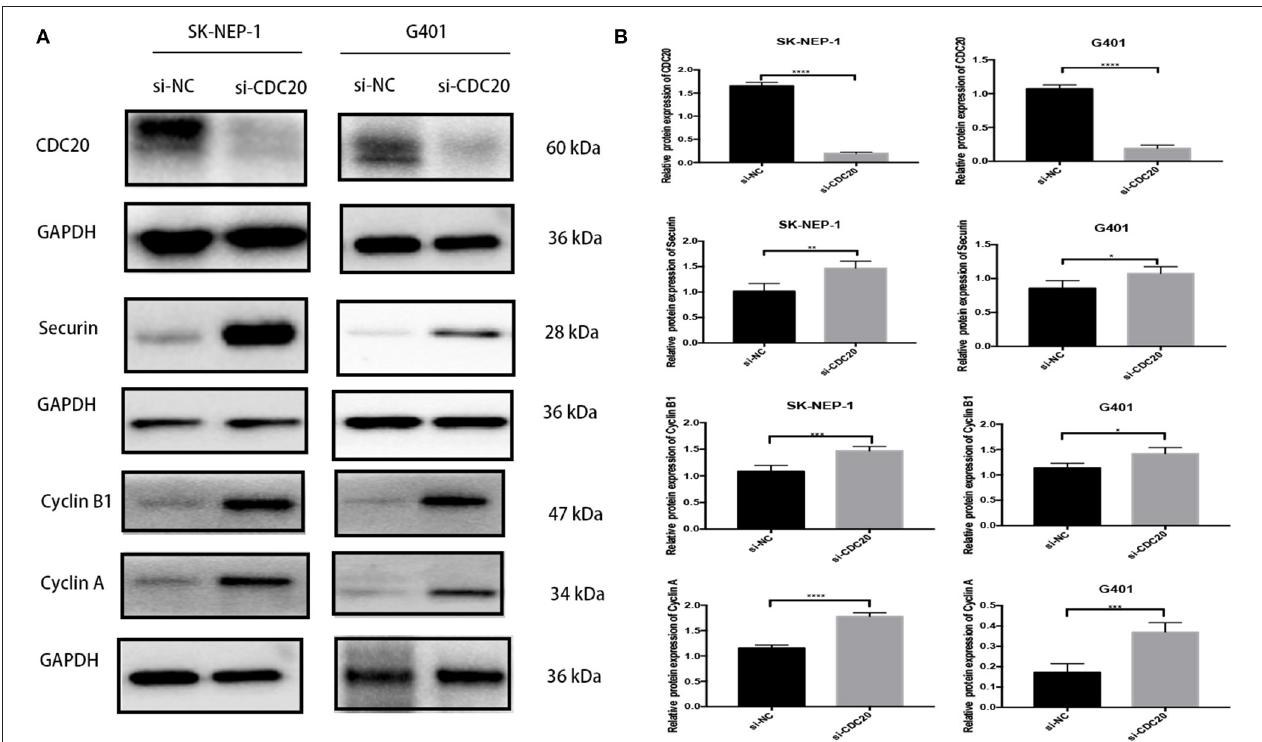
FIGURE 5 | Western blot analyses of proteins that regulate G2-to-M transition in WT cells lines inhibiting CDC20. Suppression of CDC20 protein expression by siRNA in SK-NEP-1 and G401 cells. Western blot analysis of CDC20, securin, cyclin B1, and cyclin A protein levels of the siCDC20 group compared with the NC group in SK-NEP-1 and G401 cells (A) . Quantification of CDC20, securin, cyclin B1, and cyclin A Western bolt in SK-NEP-1 and G401 cell lines, respectively (B) . Analysis was performed by Western blotting 72h after the siRNA transfection. Results are shown as the mean ± SD. For comparison, the Student t -test was performed. * p < 0.05, ** p < 0.01, *** p < 0.001, **** p <